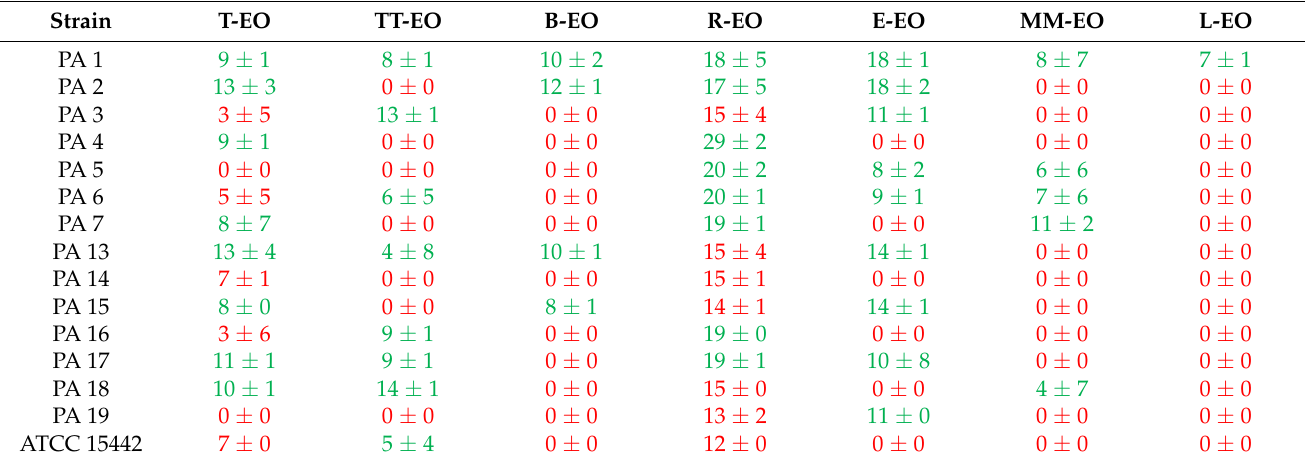
Table 2. Mean diameters of inhibition zones (mm ± standard deviation) after treatment of P. aeruginosa clinical (PA 1–7, PA 13–19) and the reference (ATCC 15442) strains with non-emulsified EOs in their liquid forms assessed with the disc diffusion method. T-EO, thyme oil; TT-EO, tea tree oil; B-EO, basil oil; R-EO, rosemary oil; E-EO, eucalyptus oil; MM-EO, menthol mint oil; L-EO, lavender oil. According to their susceptibility to a particular oil, the strains were divided into two groups of seven or eight samples per group. In the case of B-EO, MM-EO, and L-EO, the zone equal to 0 mm was the parameter for the low-susceptibility group and higher than 0 mm for the high-susceptibility one. The groups are marked as follows: red, low susceptibility among the tested strains; green, high susceptibility among the tested strains.